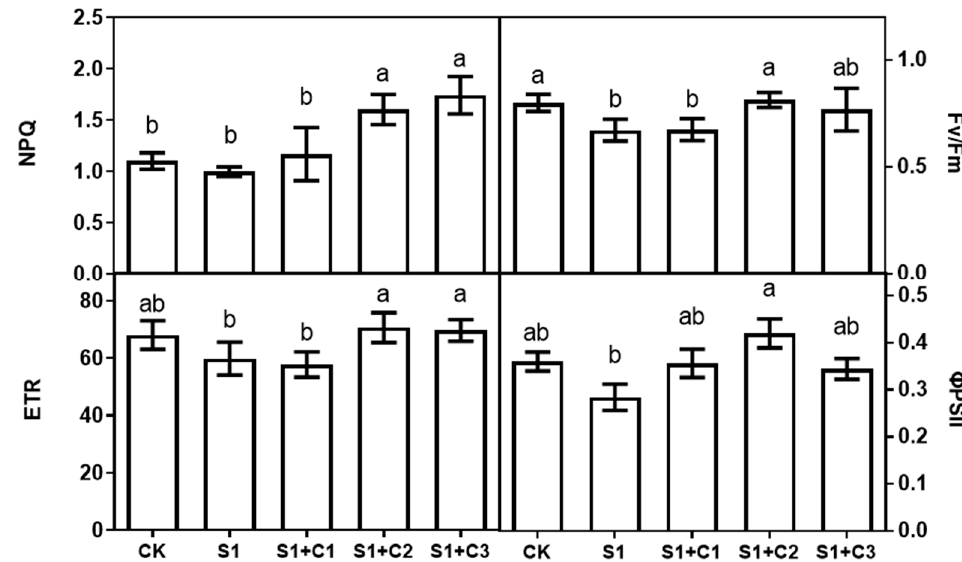
Figure 4. Effect of exogenous calcium on the fluorescence characteristics of leaves of G. sinensis . NPQ, non-photochemical quenching coefficient; Fv/Fm, maximum photochemical efficiency; ETR, apparent electron transport rate; Φ PSII, actual photochemical quantum efficiency. The hydroponic three-week G. sinensis plants grew under normal conditions and were simultaneously treated with 100 mmol/L NaCl and CaCl 2 at concentrations of 0, 5, 10, and 15 mmol/L. After one week of treatment, the leaves were measured using a portable chlorophyll fluorescence instrument (PAM-2500). The data were obtained on the basis of three independent replicates. The average value was SD. The mean values represented by the different letters were significantly different in Tukey’s test at p < 0.05.